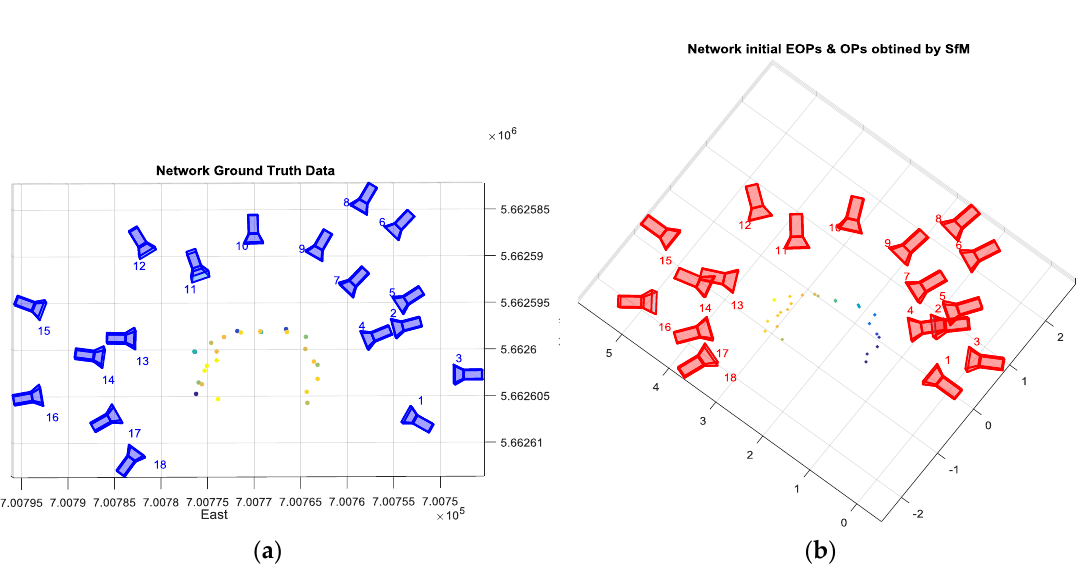
Figure 10. ( a ) The reference 3D model; ( b ) 3D model obtained by SfM.